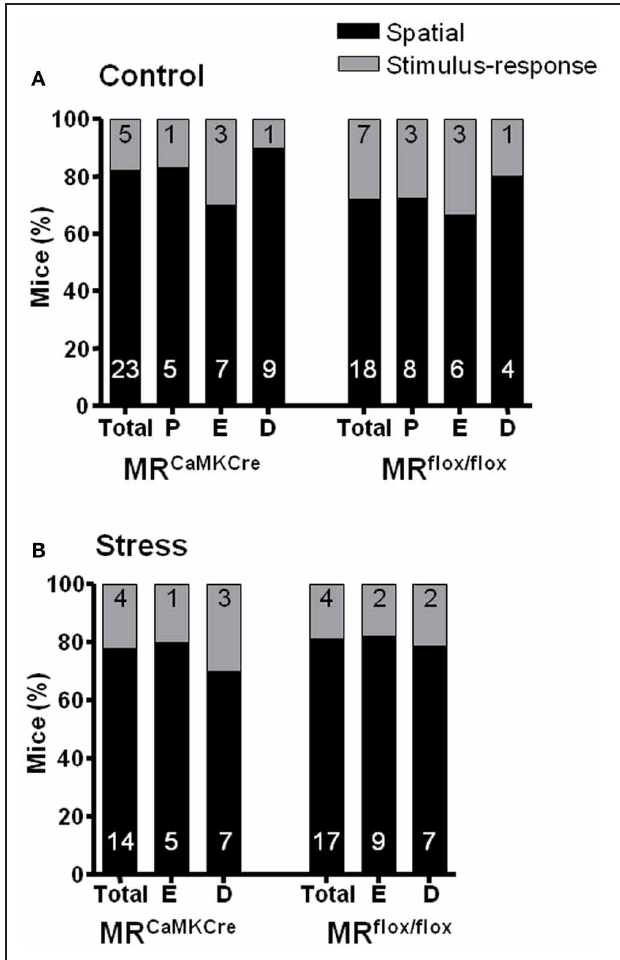
FIGURE 3 | Percentage of mice using Spatial or Stimulus-response strategies revealed by the test trial. No effect of the estrous cycle on strategies in (A) control and (B) stressed mice. Numbers in the bars represent the number of mice using the strategy. Black bar denotes the spatial strategy and the gray bar the stimulus–response strategy. D, diestrus; E, estrus; P, proestrus.